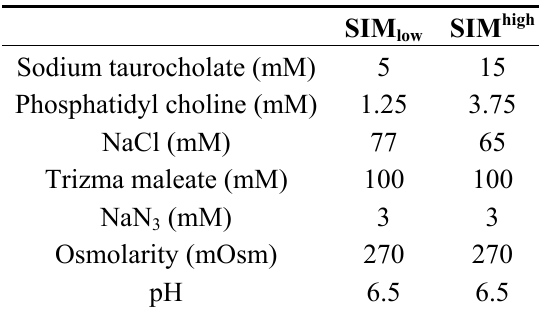
Table 3. Composition of